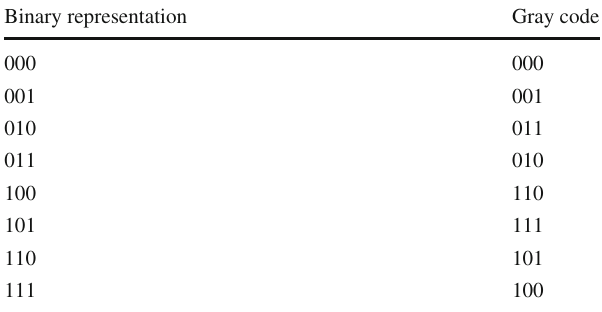
Table 1 A simplified example for the representation of Gray code Binary representation Gray